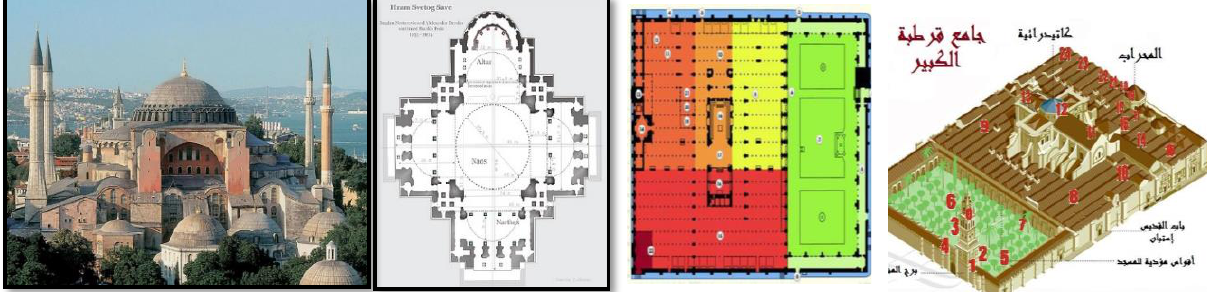
Fig. 3. Katdariah-Cordoba Mosque. Fig. 2. The church of Hagia Sophia.